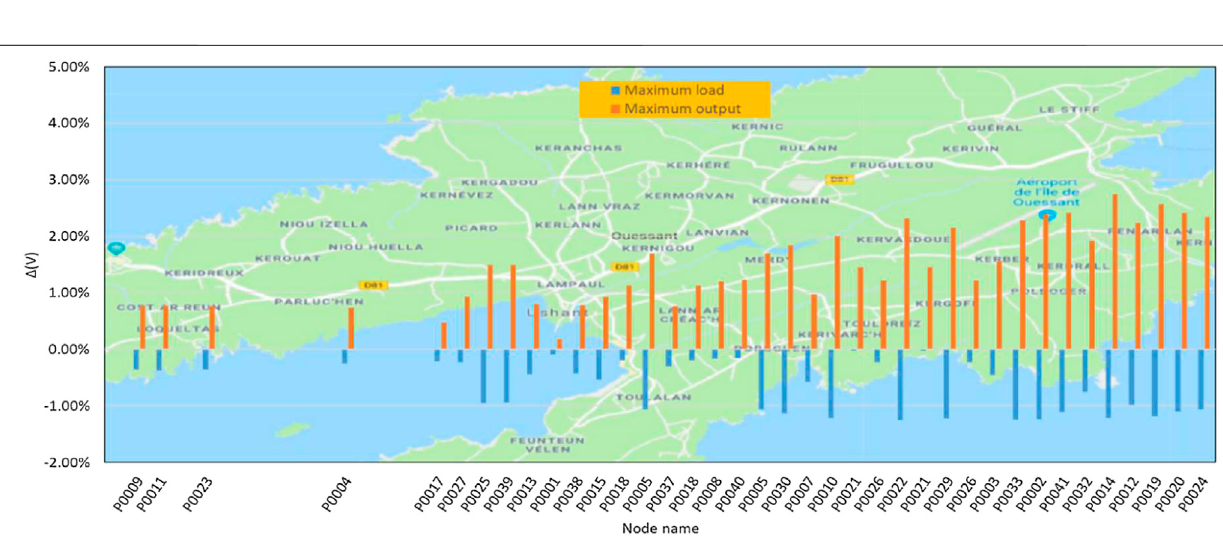
Frontiers in Energy Research |